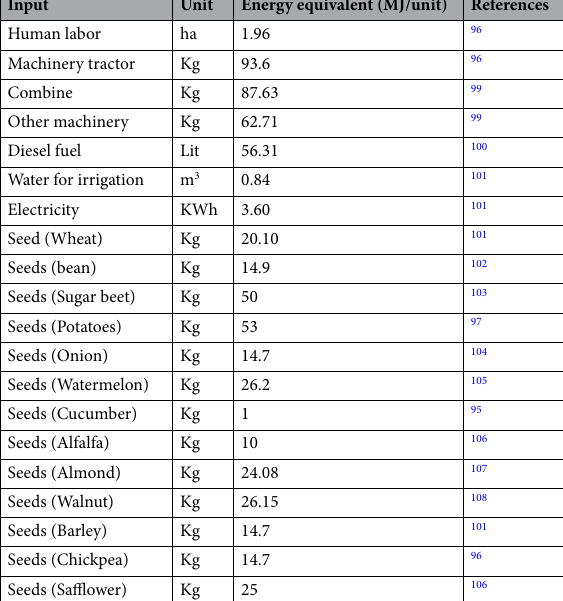
Table 19. Energy intensity data for agricultural activities on the